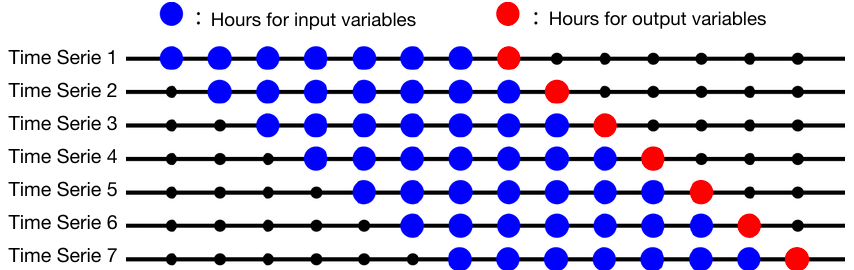
Figure 4. Visualization of sliding-window procedure for the generation of time series considering 7 hours of input and 1 hour of output.